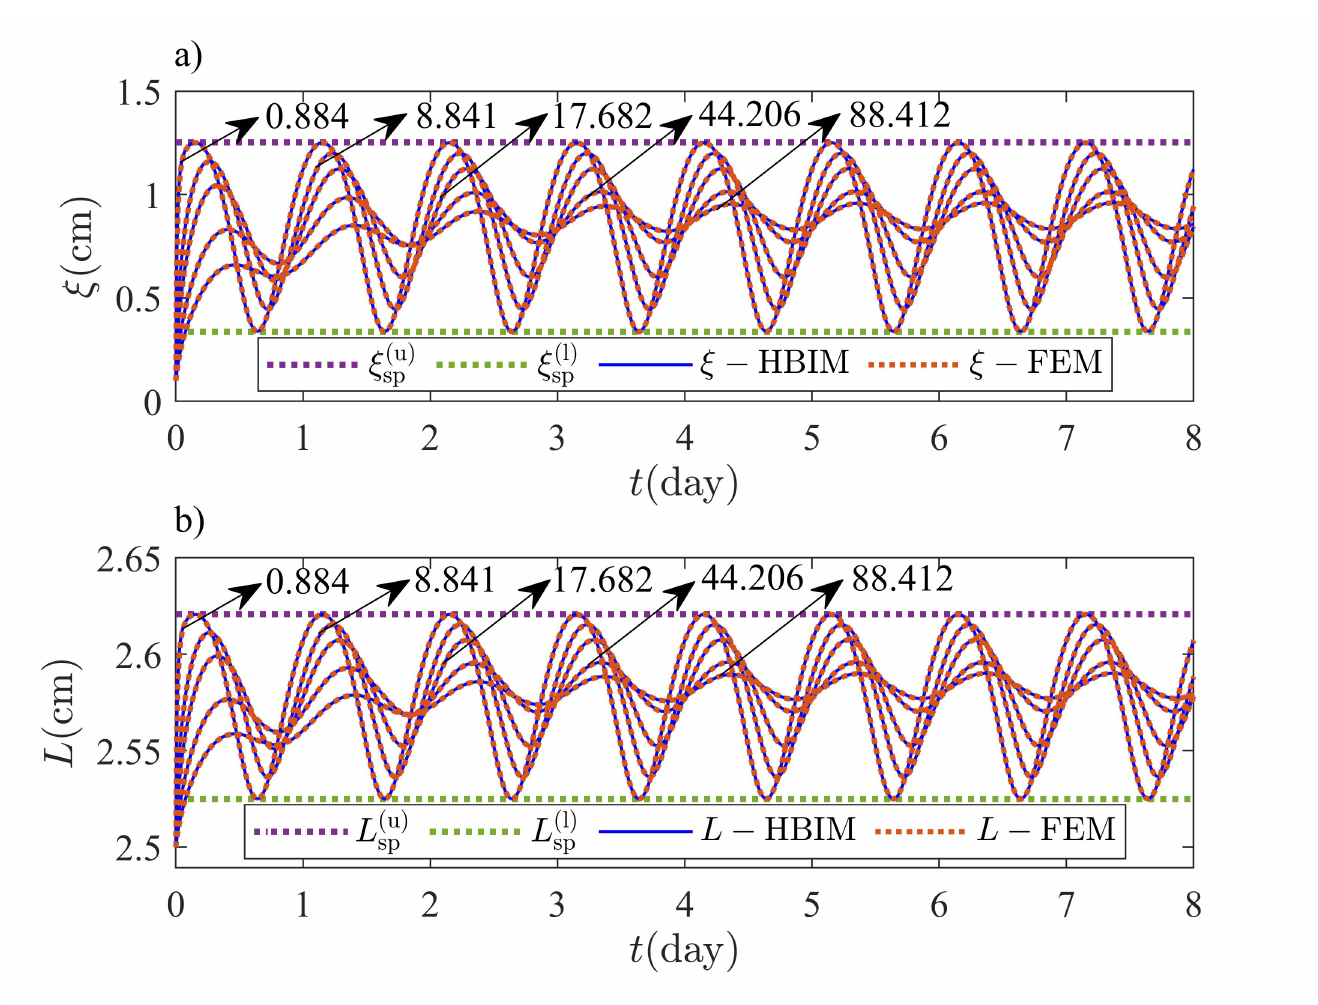
Figure 8. Transient and steady periodic behavior of ξ 1 ( t ) and L ( t ) , and for several values of the Stefan number. Solid and dashed lines represent HBIM and FEM solutions, respectively for: ( a ) ξ 1 ( t ) and ( b ) layer thickness L ( t ) . The amplitude of the oscillations in ξ 1 ( t ) and L ( t ) are tuned through the Stefan number by changing the value of L f . Corresponding values of the Stefan number are indicated through black arrows. Lower and upper bounds in the steady periodic regime given by Equations (5)–(8) are shown through horizontal dotted